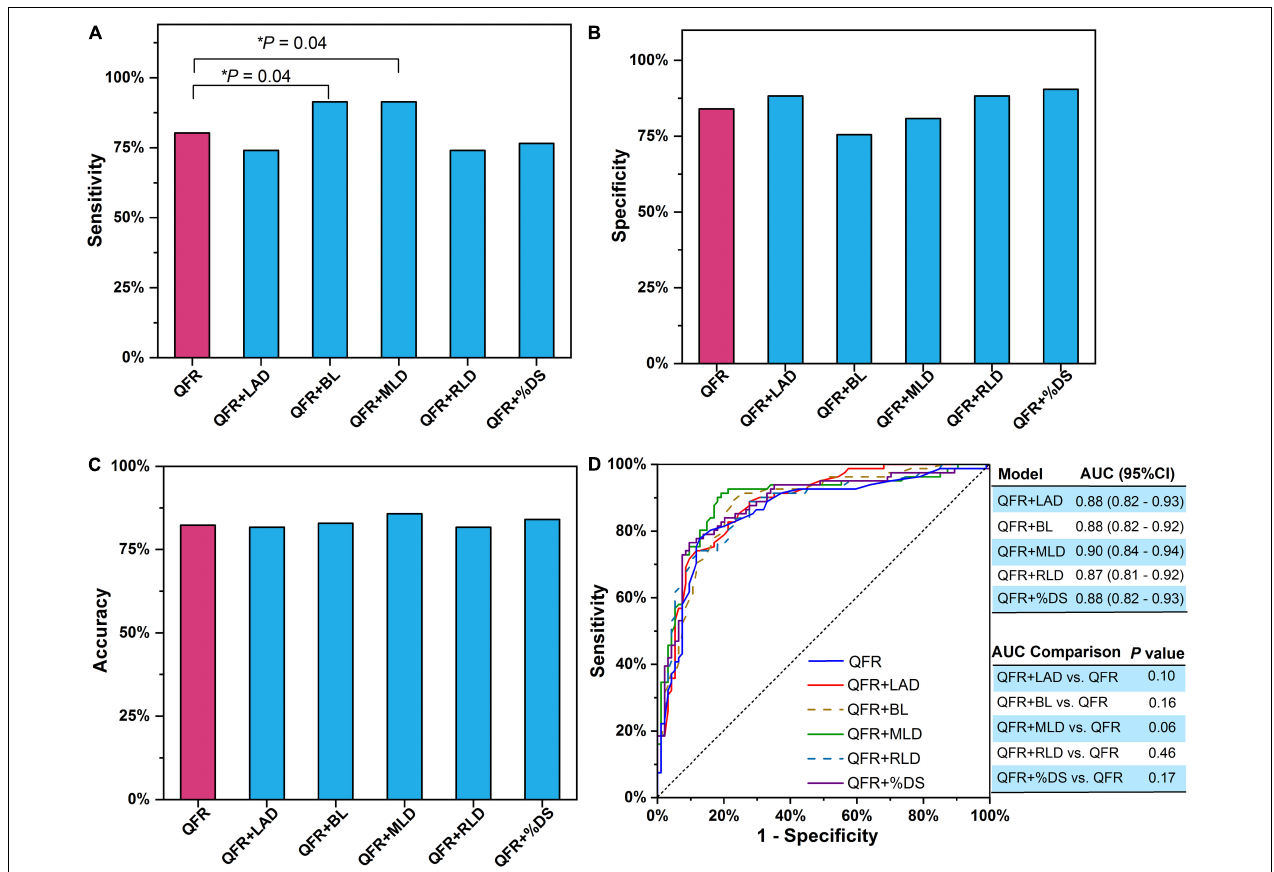
FIGURE 4 | Single lesion parameter combined with QFR for predicting myocardial ischemia. (A) Sensitivity. (B) Specificity. (C) Accuracy. (D) AUC. The P -value reflects the AUC comparison between the combined model and QFR. QFR, quantitative flow ratio; LAD, left anterior descending artery; MLD, minimal lumen diameter; RLD, reference lumen diameter; %DS, percent diameter stenosis; BL, side branch at lesion site; ML, multiple lesions with %DS > 30%; AUC, area under receiver operator characteristic curve; CI, confidence interval. The symbol * means the related P value is statistically significant with less than